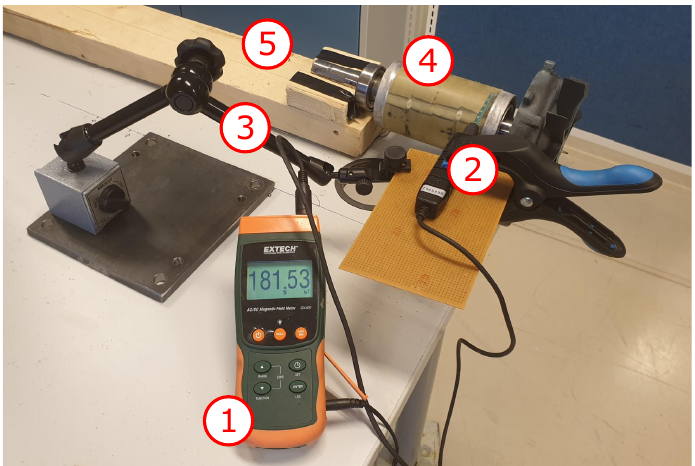
Figure 5. Setup for magnet strength measurement: (1) Extech magnetic AC/DC magnetic field meter, (2) measurement rod, (3) universal magnetic stand, (4) PM rotor, and (5) wooden